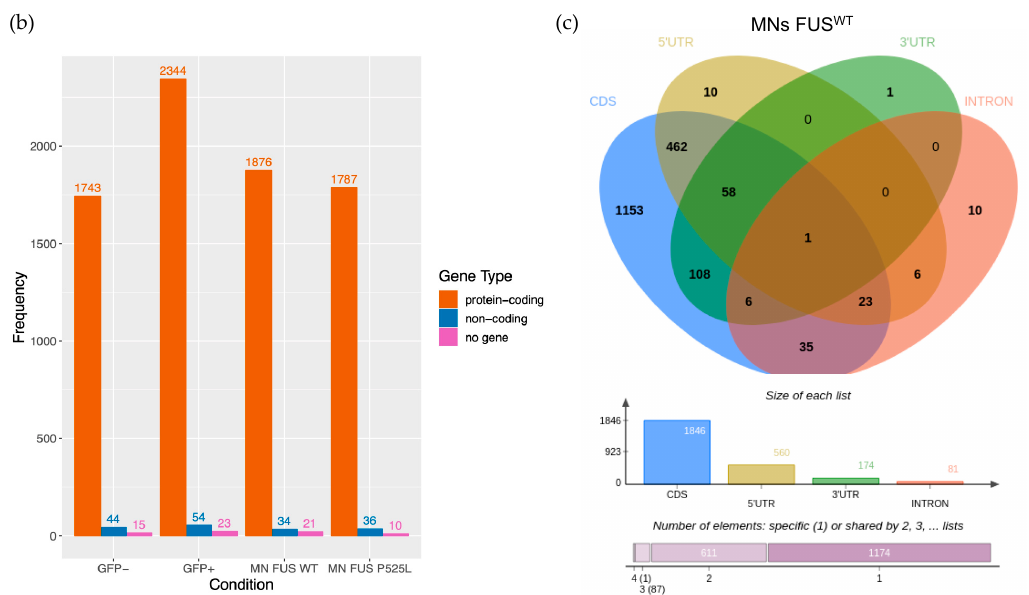
Figure 1. Distribution of circRNAs in iPSCs-derived MN precursors and mature MNs. ( a ) UpSet plot showing the number of circRNAs identified (average CPM > 1) in GFP-, GFP+, FUS WT , and FUS P525L cell types, as well as the overlap between such conditions. ( b ) Bar chart showing, for each cell type, the number of circRNAs hosted by protein-coding genes, non-coding genes, and intergenic regions (no gene). ( c ) Venn diagram and bar charts showing the protein-coding gene regions occupied by the circRNAs detected in MN FUS WT samples. CDS: coding sequence; 5 ′ UTR: 5 ′ untranslated region; 3 ′ UTR: 3 ′ untranslated region; INTRON: intronic region. We focused on circRNAs expressed in FUS WT or FUS P525L pure MNs and carried out a differential expression analysis to detect circRNAs deregulated in the cells carrying the mutant protein. We found 121 deregulated circRNAs ( p -value < 0.05) and, among them, the majority (86) were downregulated in the mutant condition (Figure 2 and Table S2). We also quantified the linear counterparts in FUS WT and FUS P525L MNs, using the reads spanning linear splicing junctions, and evaluated their differential expression.